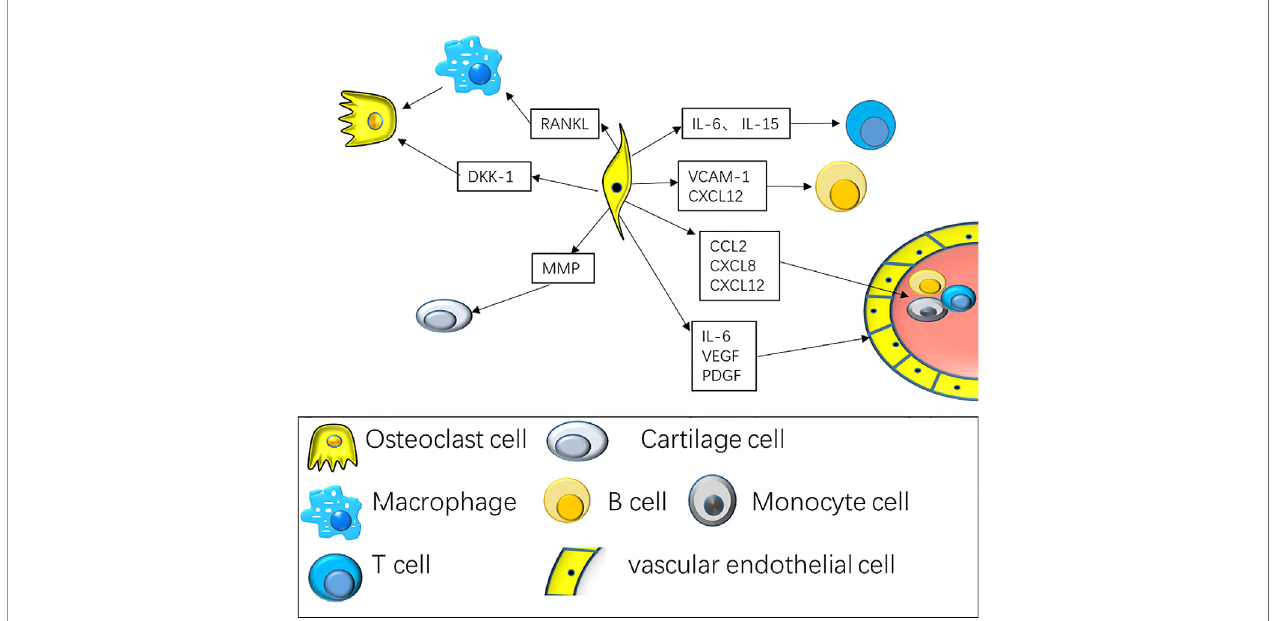
FIGURE 2 | Synovial fi broblasts interact with various types of immune cells to maintain synovitis and continued bone destruction. The interaction of fi broblasts with T cells along with B cells includes the secretion of cytokines consisting of CXCL8, CCL2, CCL5, to promote the mobilization and retention of T cells and B cells. At the same time, fi broblasts cytokines consisting of IL-6 and IL-15 are speci fi cally remarkable for the differentiation of Th17 cell subsets; Fibroblasts promote angiogenesis by secreting VEGF, PDGF. Fibroblasts secrete RANK Ligand, that enhances osteoclast differentiation along with activation resulting in bone erosion, and DKK-1 that represses anabolic osteoblast function, averting repair of bone